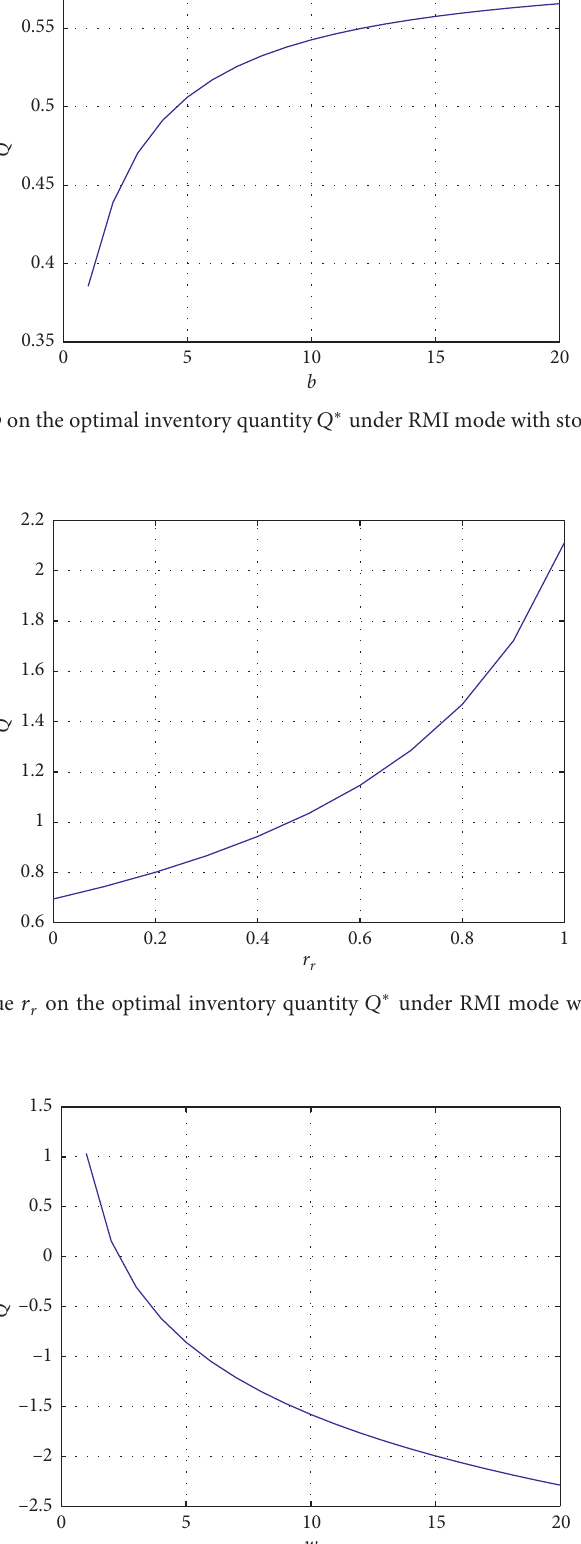
Figure 11: Effect of wholesale price w on the optimal inventory quantity Q ∗ under RMI mode with stochastic demand in the water supply